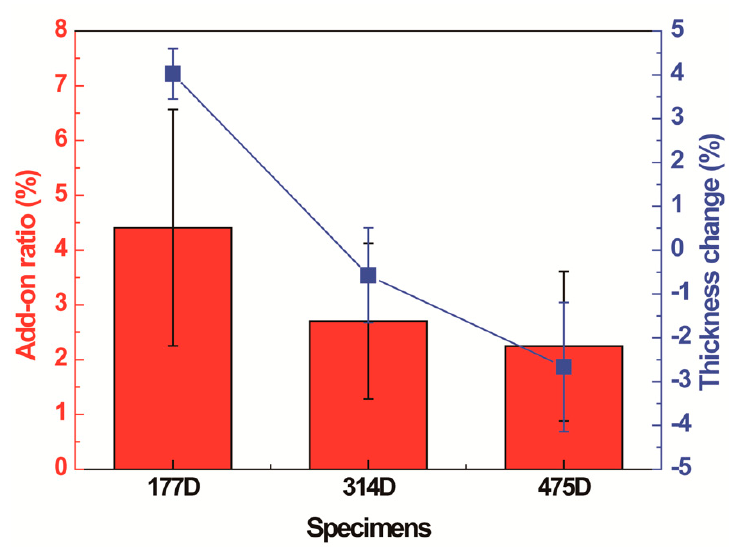
Figure 11. Changes in the add-on ratio and thickness of 177D, 314D, and 475D after 1 v / v % PDMS coating for 4 min.